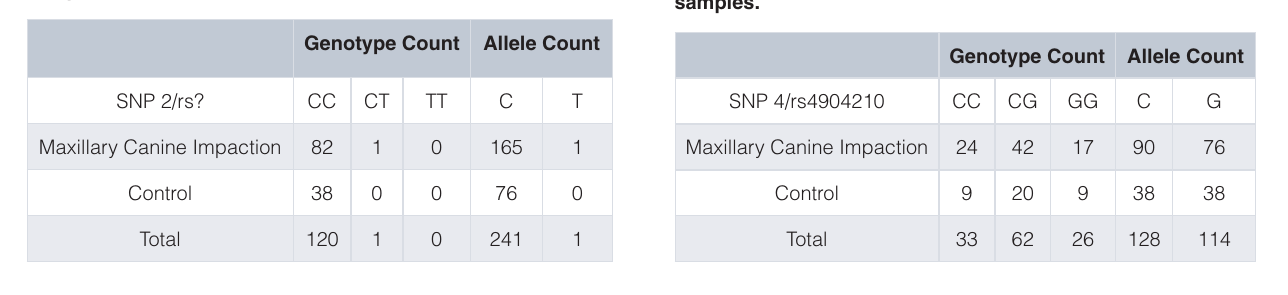
Table 5. Genotype analysis of SNP 2 in case and control samples.